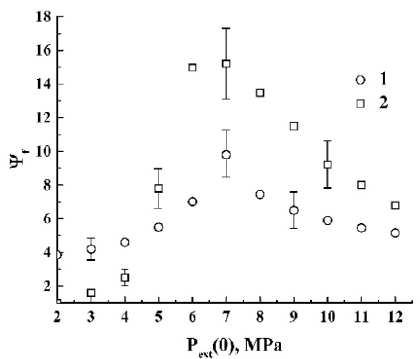
Figure 6. The values of Ψ f against P ext ( 0 ) for the quasi-adiabatically (1) and quasi-isothermally (2) expanding polylactide foams. The dataset (1) was taken from [38]. The selectively shown error bars correspond to the confidence level of 0.9.